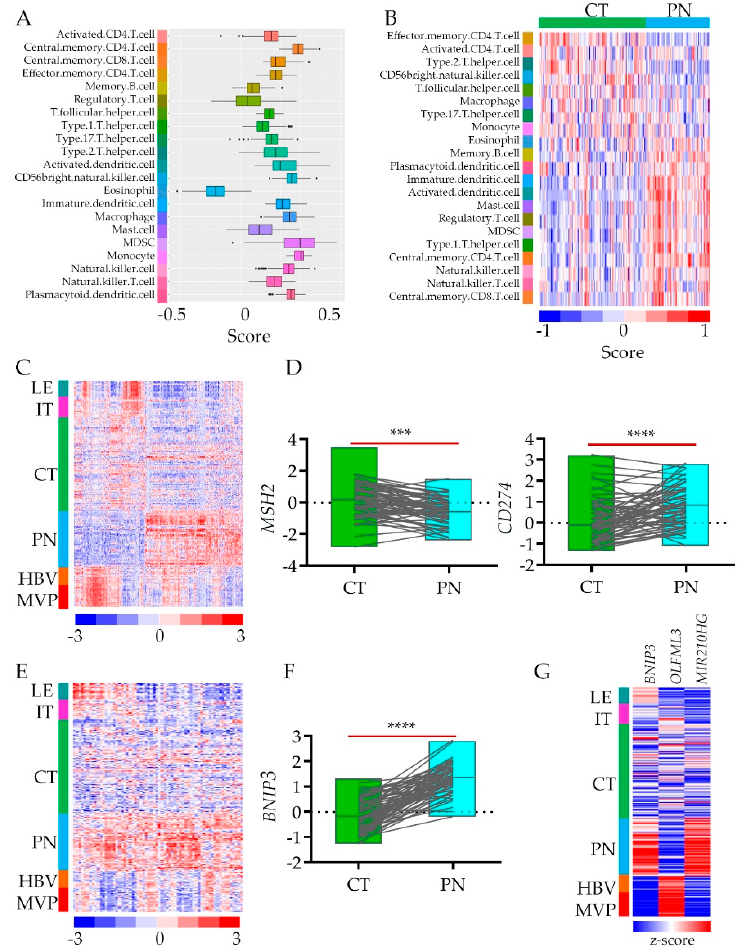
Figure 3. Immune and Autophagy modes enrichment analysis in hypoxic feature using Ivy GAP database: ( A ) Estimation of immune cells enrichment in PN vs. CT glioblastoma anatomic features